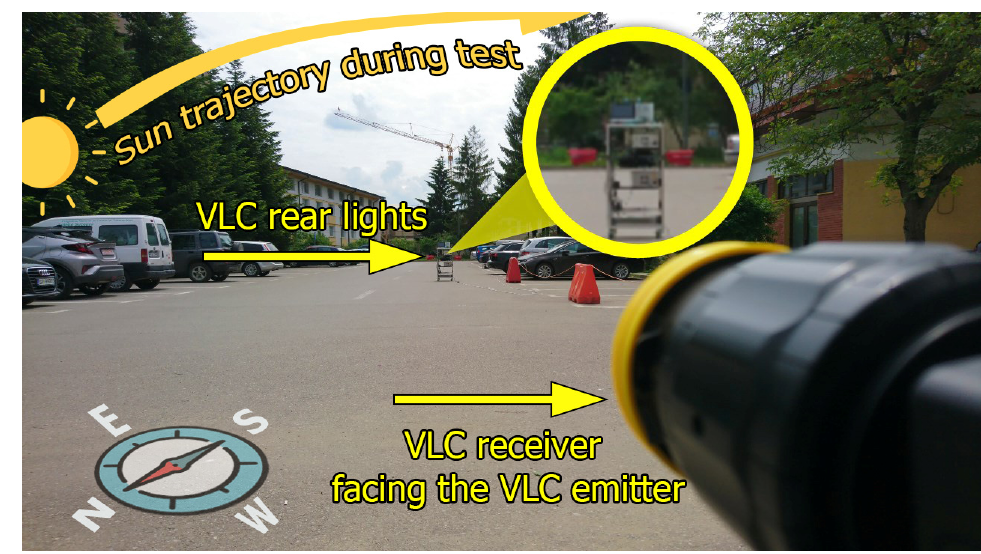
Figure 14. Outdoor experimental setup.